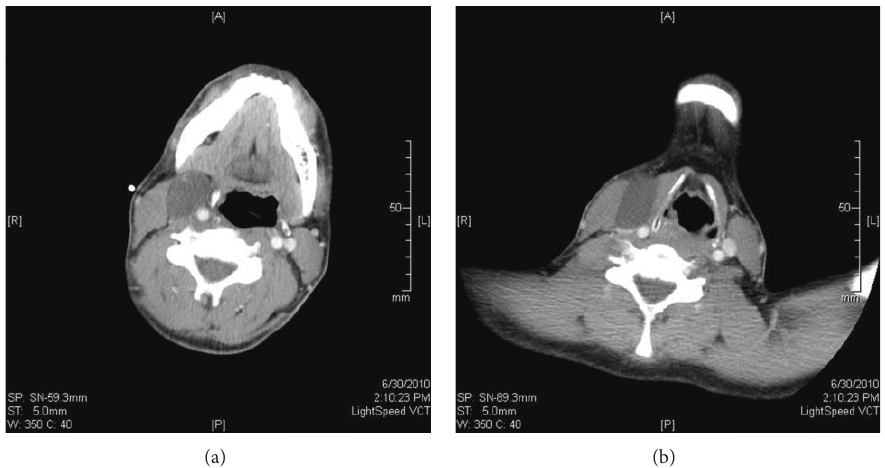
Figure 2: Axial CT Scan with contrast showing the cystic neck mass lateral to the great vessels.